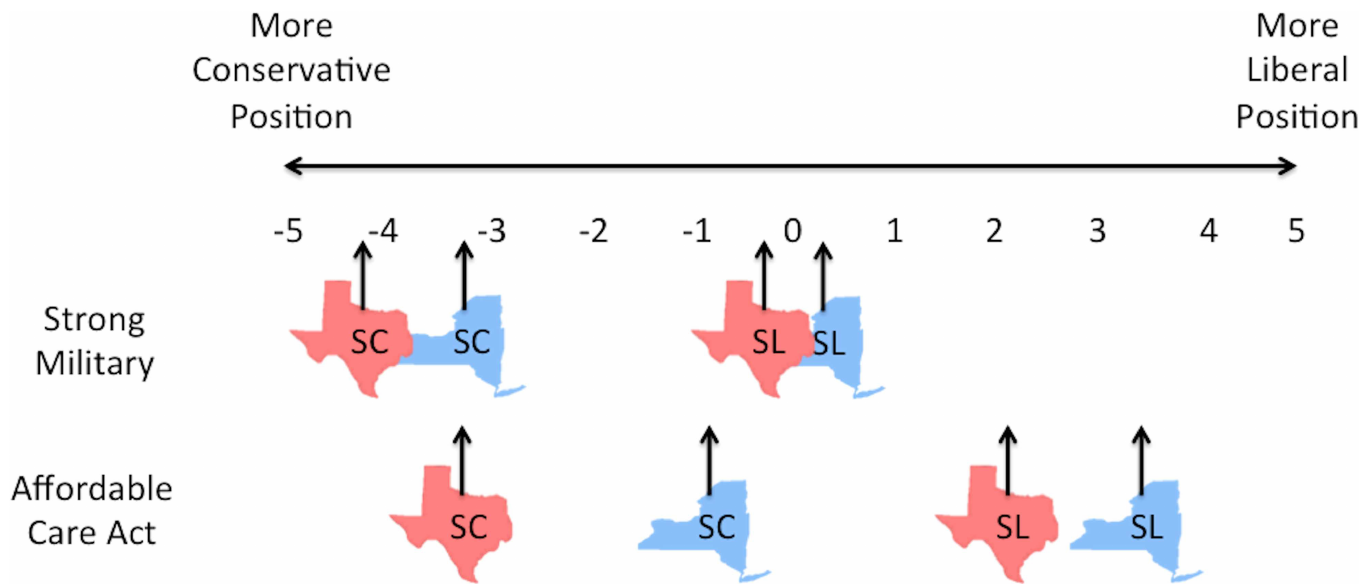
Fig 4. An illustrative example of the effect of location on policy position. SC = strong conservative identity; SL = strong liberal identity. Red Texas symbols represent peoplein the 100 reddest countiesin America; Blue New York symbols representpeoplein the 100 bluest countiesin America. One conservative and one liberal issue were chosen for illustrative purposes. Data are from Study